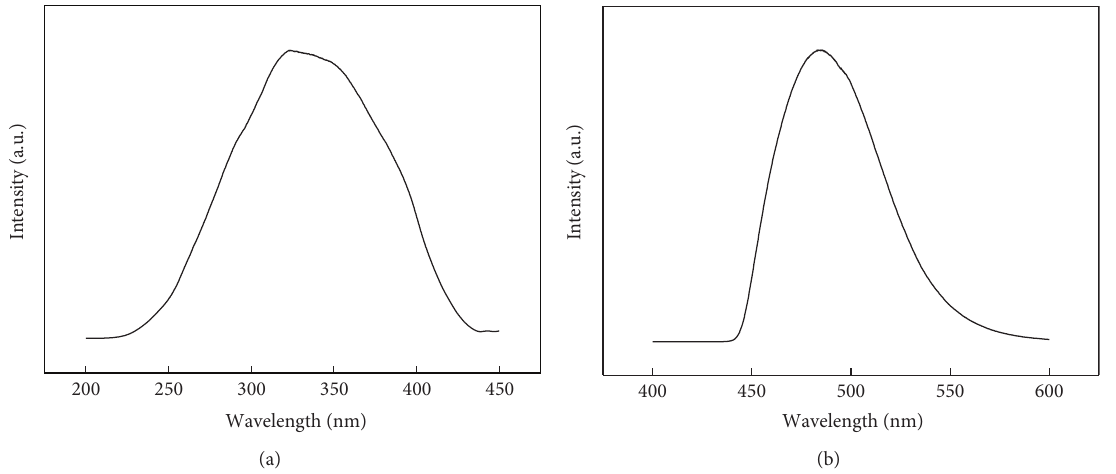
F 2: Excitation spectrum (a) and emission spectrum (b) of Sr